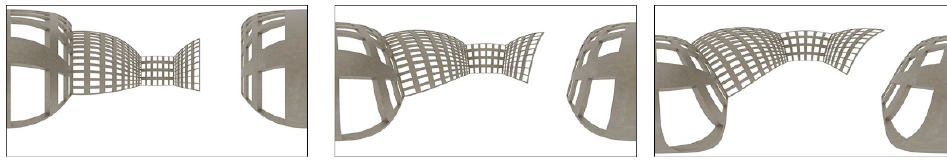
Figure 2. Changing the viewing angle axis leads to curvilinear distortion.